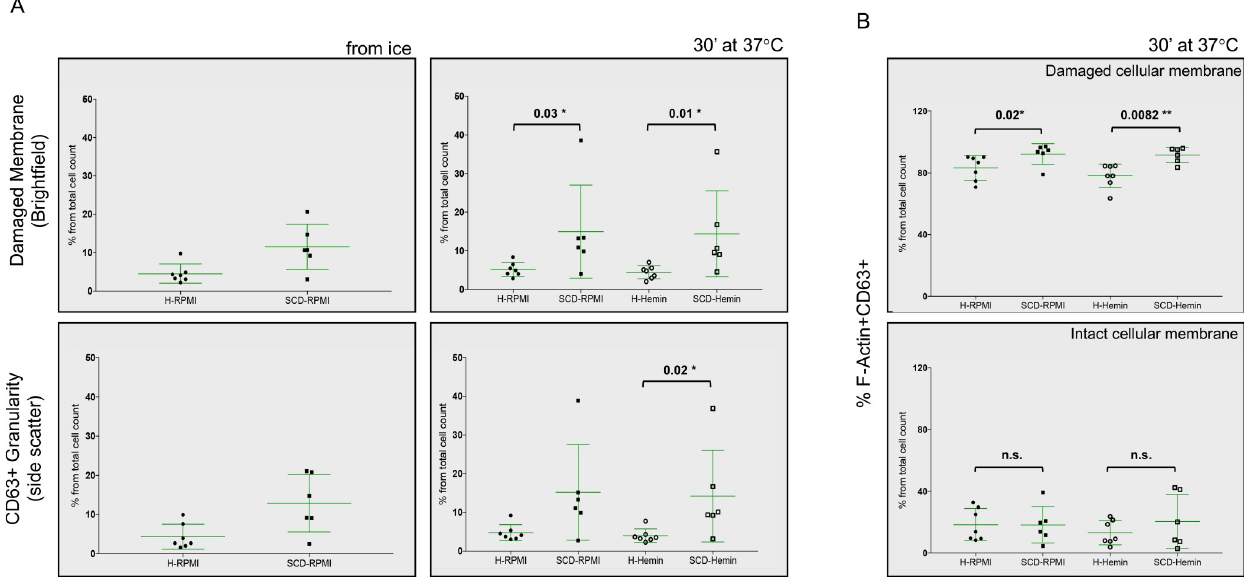
Fig 3. SCD neutrophils show increased degranulation-associated cellular changes, in the absence and presence of a stimulus. (A) In IFC, standard deviation versus modulation and SSC (side scatter) were used to asses cellular membrane damage and granularity in neutrophils from healthy controls (H) and that from SCD patients in steady-state (SCD) immediately following the purification step (left panels) or after 30 minutes incubation in RPMI or 20 μ M hemin (right panels). (B) Purified and rested neutrophils from healthy controls (H) and that from SCD patients in steady-state (SCD) were left in RPMI or treated with 20 μ M hemin for 30 minutes and percentage of the F-actin/CD63 double positive neutrophils with normal multi-lobulated nuclei that had damaged cell membranes (upper panel) or intact cell membranes (lower panel) was determined. (Healthy N = 7; SS N = 6). Data presented as dot plots ± S.D., significance calculated with an unpaired Mann-Whitney